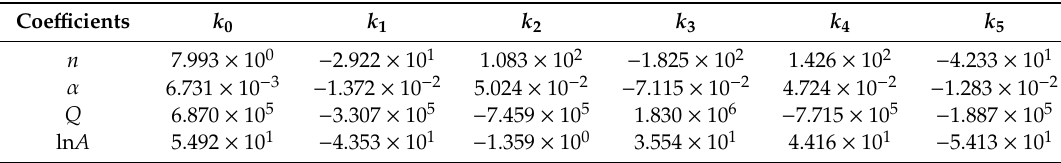
Table 2. Coefficients of the polynomials. Table 2. Coe ffi cients of the